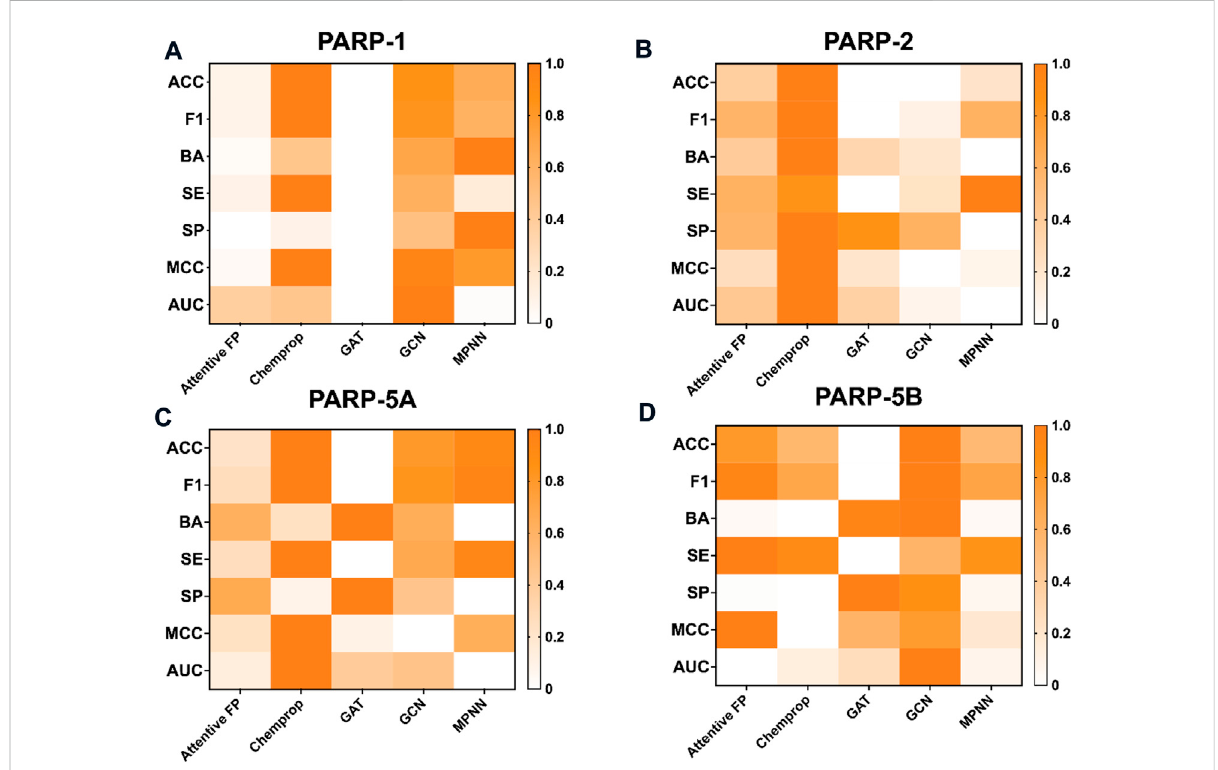
FIGURE 5 Performance of graph-based DL models on the test sets of PARP-1 (A) , PARP-2 (B) , PARP-5A (C) , and PARP-5B (D)